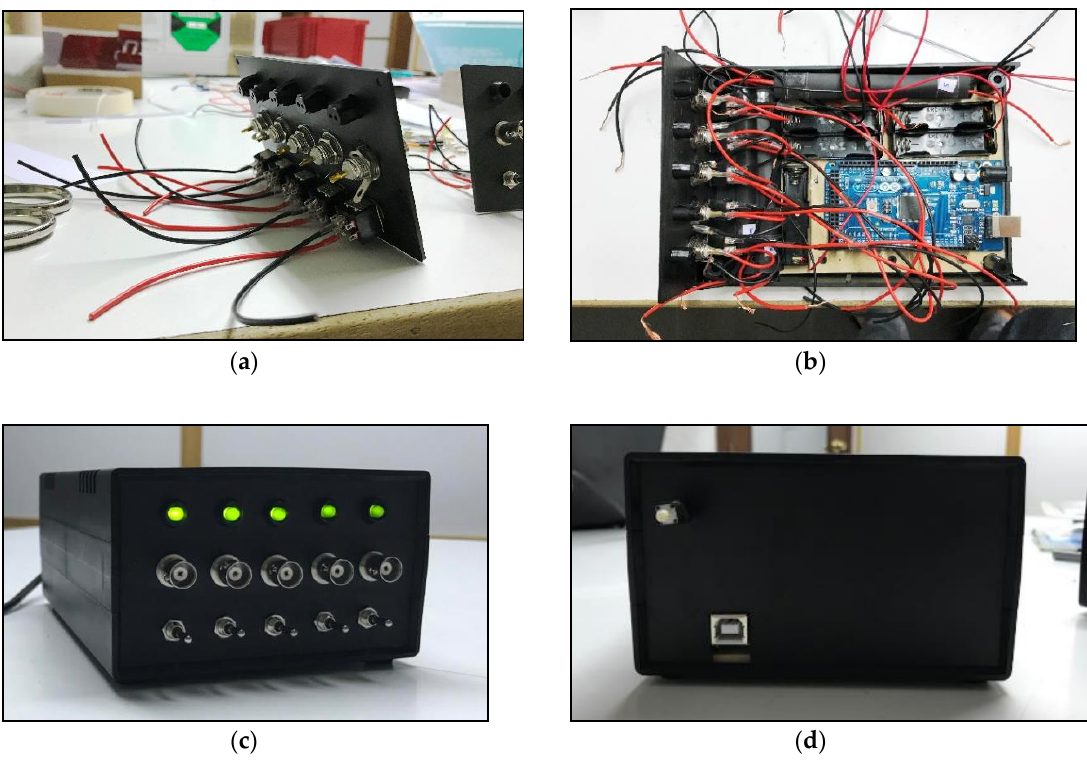
Figure 4. Pictures of ABDAS along its development/manufacturing process. ( a ) Connectors, lightning and switching panel. ( b ) ABDAS distribution inside the enclosure. ( c ) Front view. ( d ) Rear view.